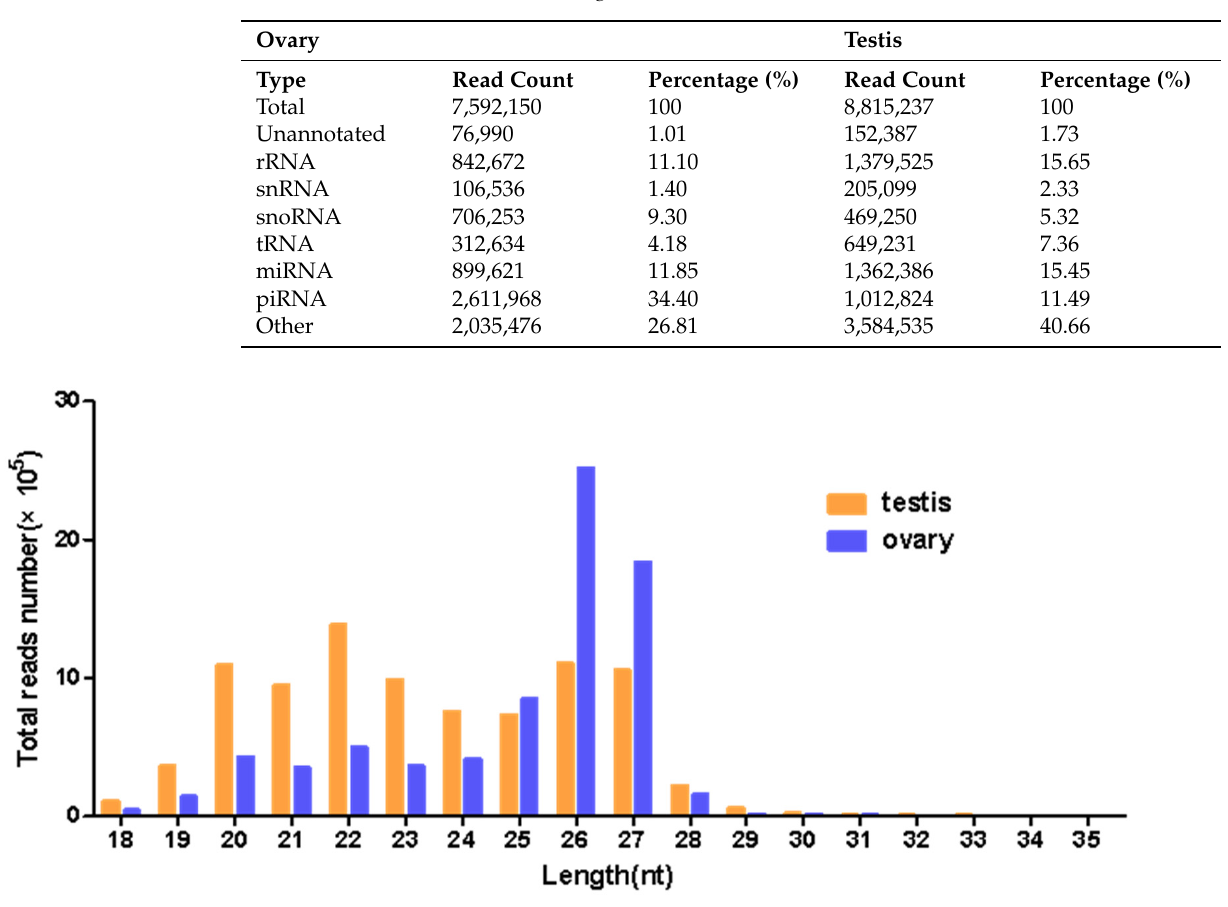
Figure 2. The length distribution of small RNAs in the testis of a 0-day-old male adult and the ovary of a 2-day-old female adult of H. armigera